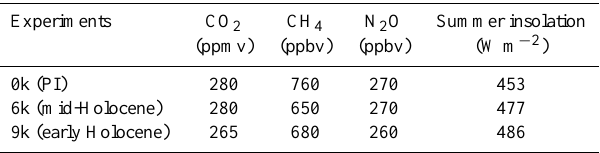
Table 1. Summary of boundary conditions used in the experiments. Summer insolation refers to 21 July at 20 ◦ N.